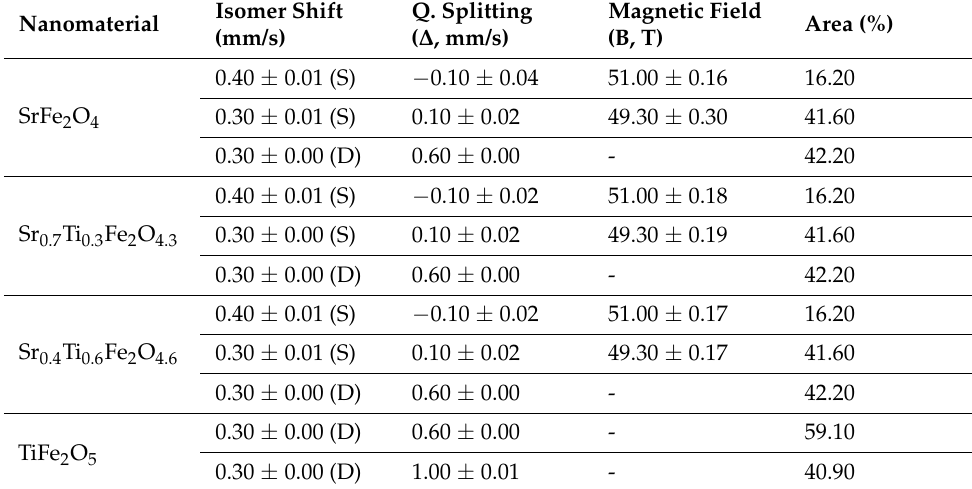
Table 3. Mössbauer parameters of SrFe 2 O 4 , TiFe 2 O 5 , Sr 0.7 Ti 0.3 Fe 2 O 4.3 and Sr 0.4 Ti 0.6 Fe 2 O 4.6